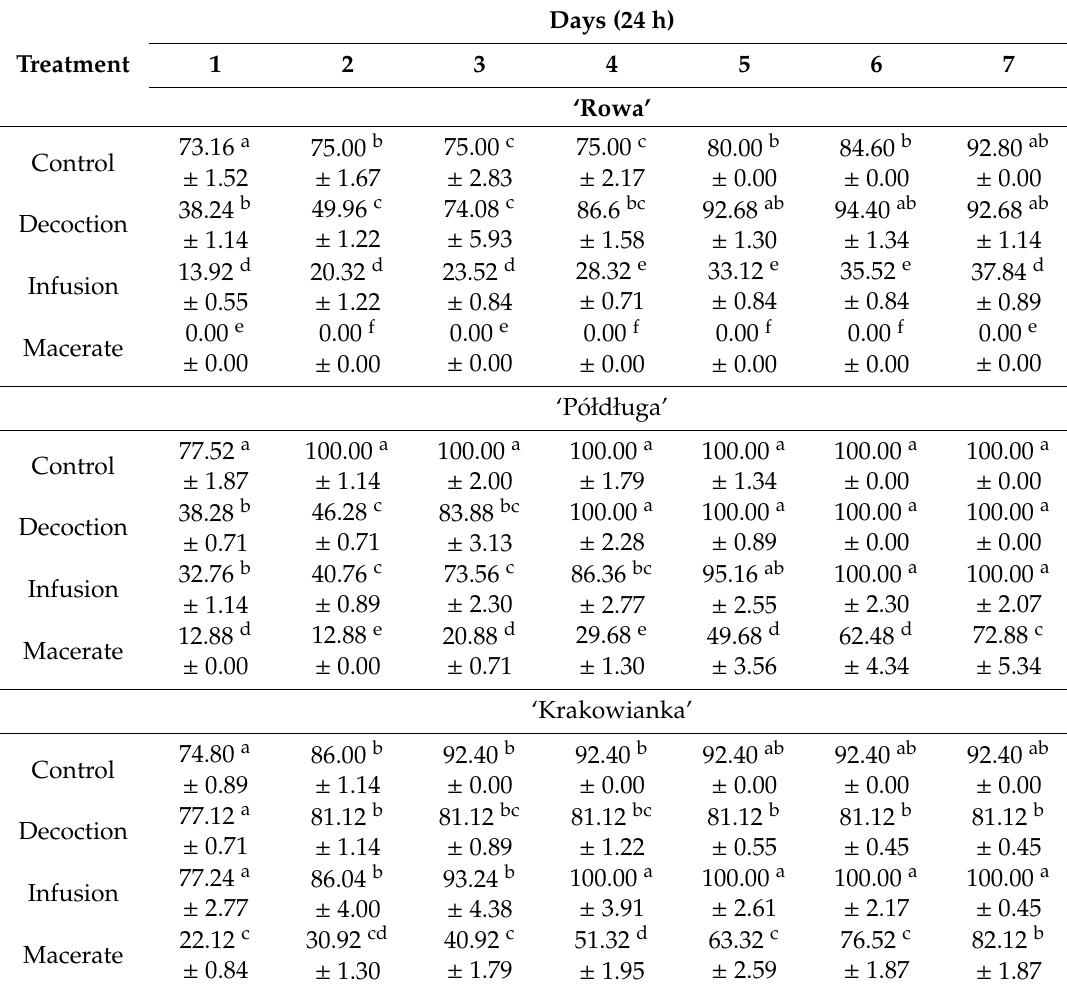
Table 1. Germination speed (GS) (%) of Raphanus sativus L. cv. Rowa, P ó łdługa, Krakowianka, on the aqueous extracts from Solidago canadensis L. leaves and distilled water (control).